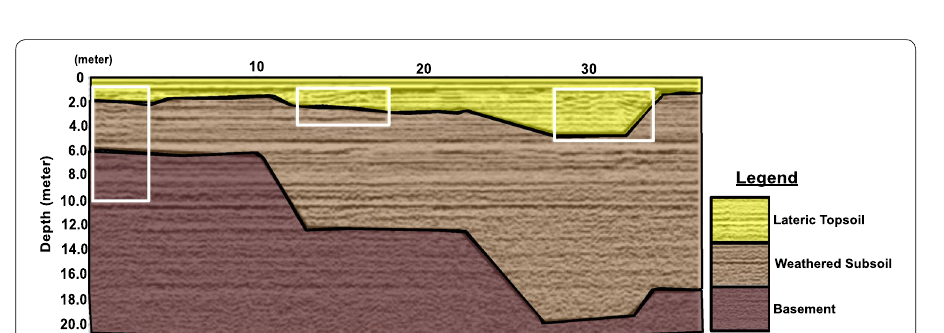
Fig. 23 GPR profile 1 overlaid on Geo-electric section traverse 1